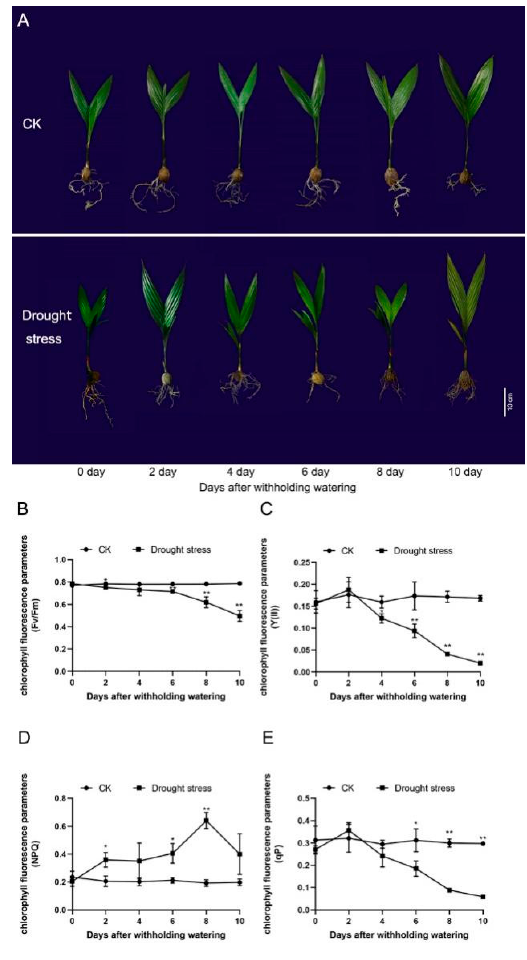
Figure 1. Growth of the areca seedlings under treatment ( n = 3). ( A ) Phenotype of the areca seed- lings. Scale bar = 10 cm. ( B ) The value of Fv/Fm. ( C ) The value of Y(II). ( D ) The value of qP. ( E ) The value of NPQ. Data are expressed as the means ± standard errors of the means. * p value < 0.05; ** p < 0.01.